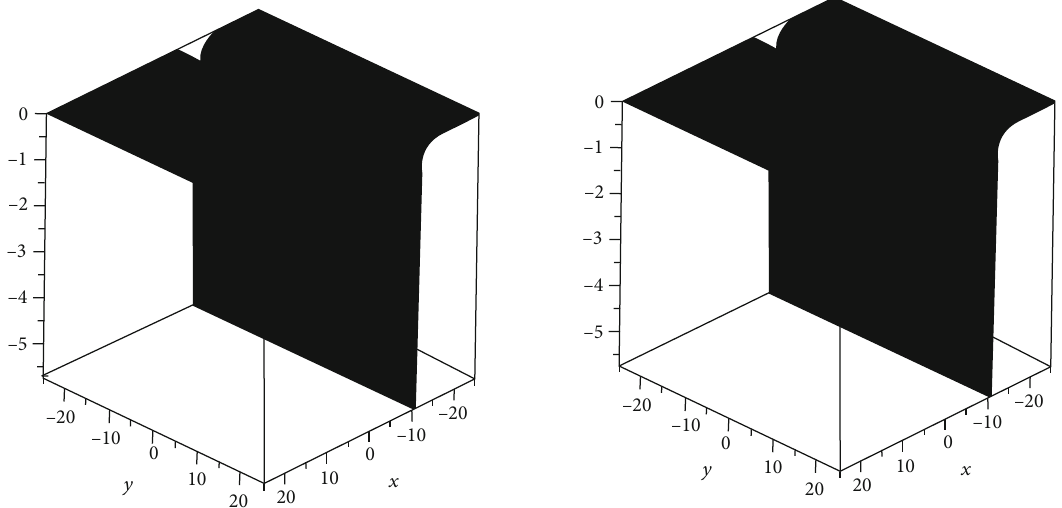
Figure 10: Graphical view of the exact and analytical solution for K ð ζ , ρ Þ at δ = 1 of system 2